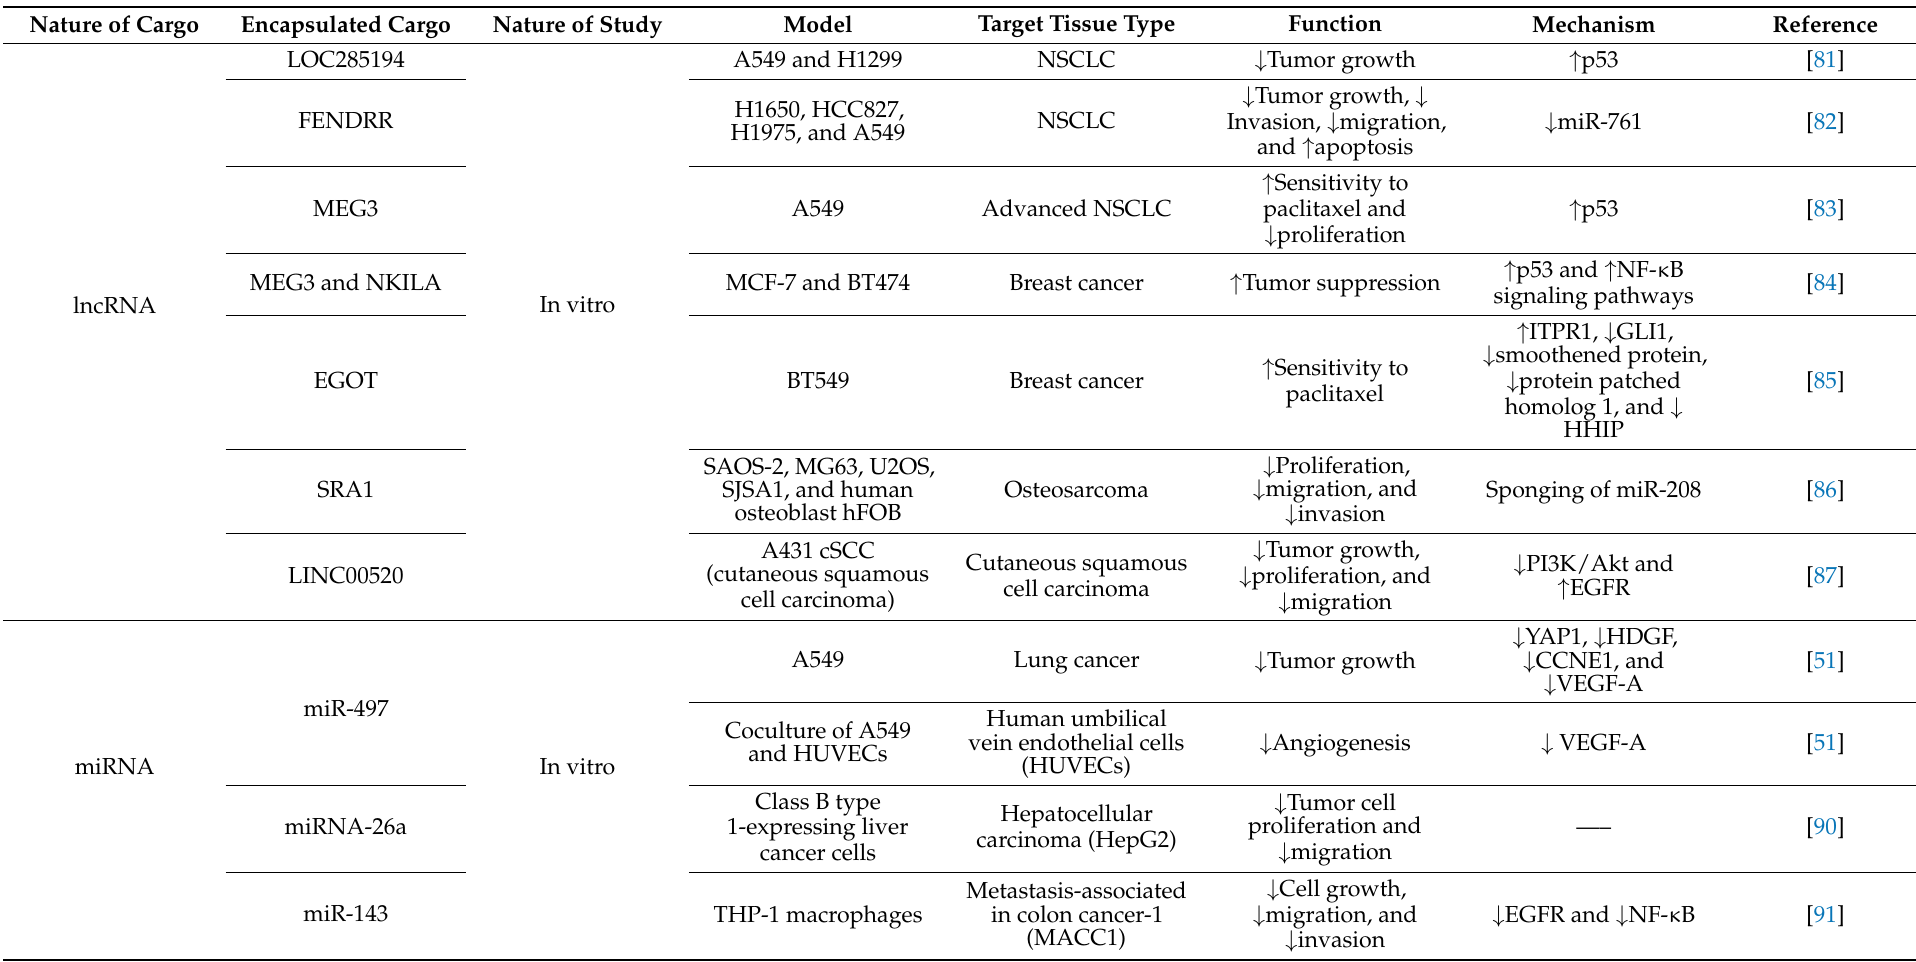
Table 3. Noncoding RNAs as exosomal cargoes for cancer prevention and therapy: noncoding RNAs such as lncRNA, miRNA, and siRNA as encapsulated cargoes, used for cancer prevention